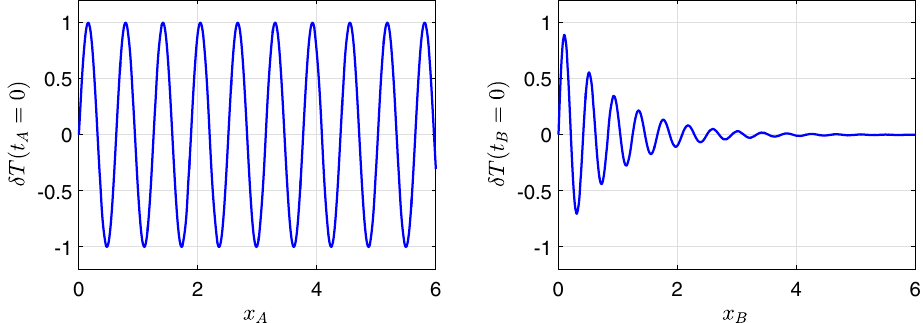
FIG. 8. The same plane wave viewed by two observers in motion with respect to each other. The full spacetime dependence of the ; x e − t A sin ð 10 x temperature perturbation is assumed to be δ T ð t . In the “ ( A ) ” frame, we have a conventional Fourier mode (left A A Þ ¼ A Þ panel), whose amplitude decays in time. In the “ ( B ) ” frame, there is an exponential modulation also in space (right panel). This is a direct consequence of the relativity of simultaneity: If something decays only in time in one frame, it may decay both in time and space in another frame. We choose the boost velocity v ¼ 3 = 4 , which corresponds to the Lorentz factor γ ≈ 1 . 5